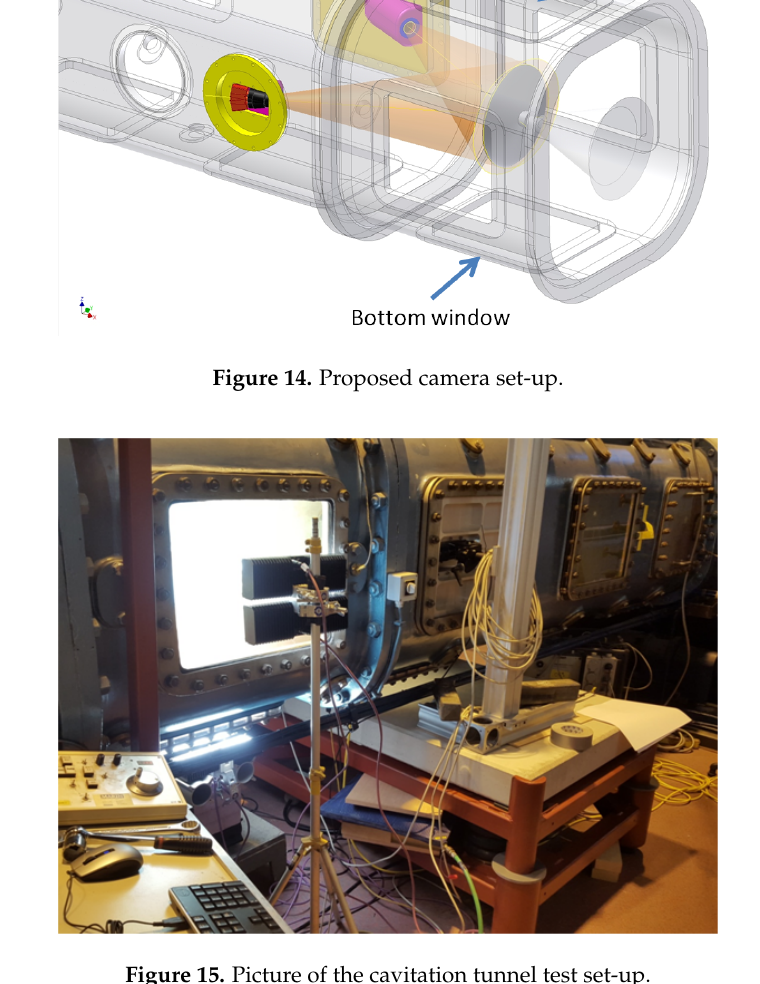
Figure 15. Picture of the cavitation tunnel test